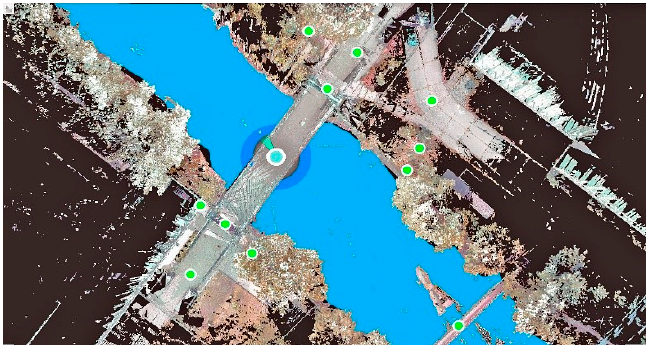
Figure 4. Top view of the arrangement of optimized locations of laser scanner and digital camera.